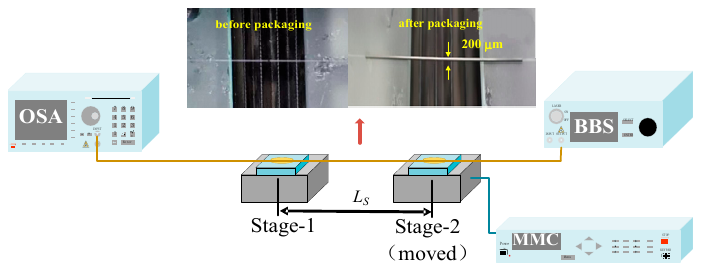
Figure 6. Experimental setup for axial-strain test.